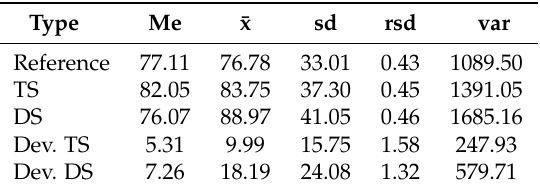
Table 4. Results of GT testing—the reference database.